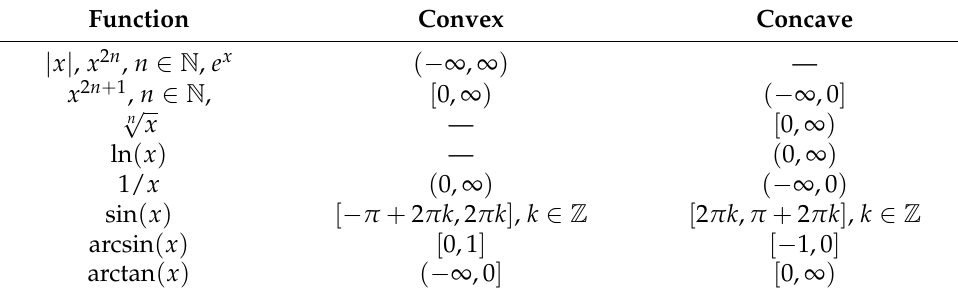
Table 3. The convexity/concavity of elementary functions. Function Convex